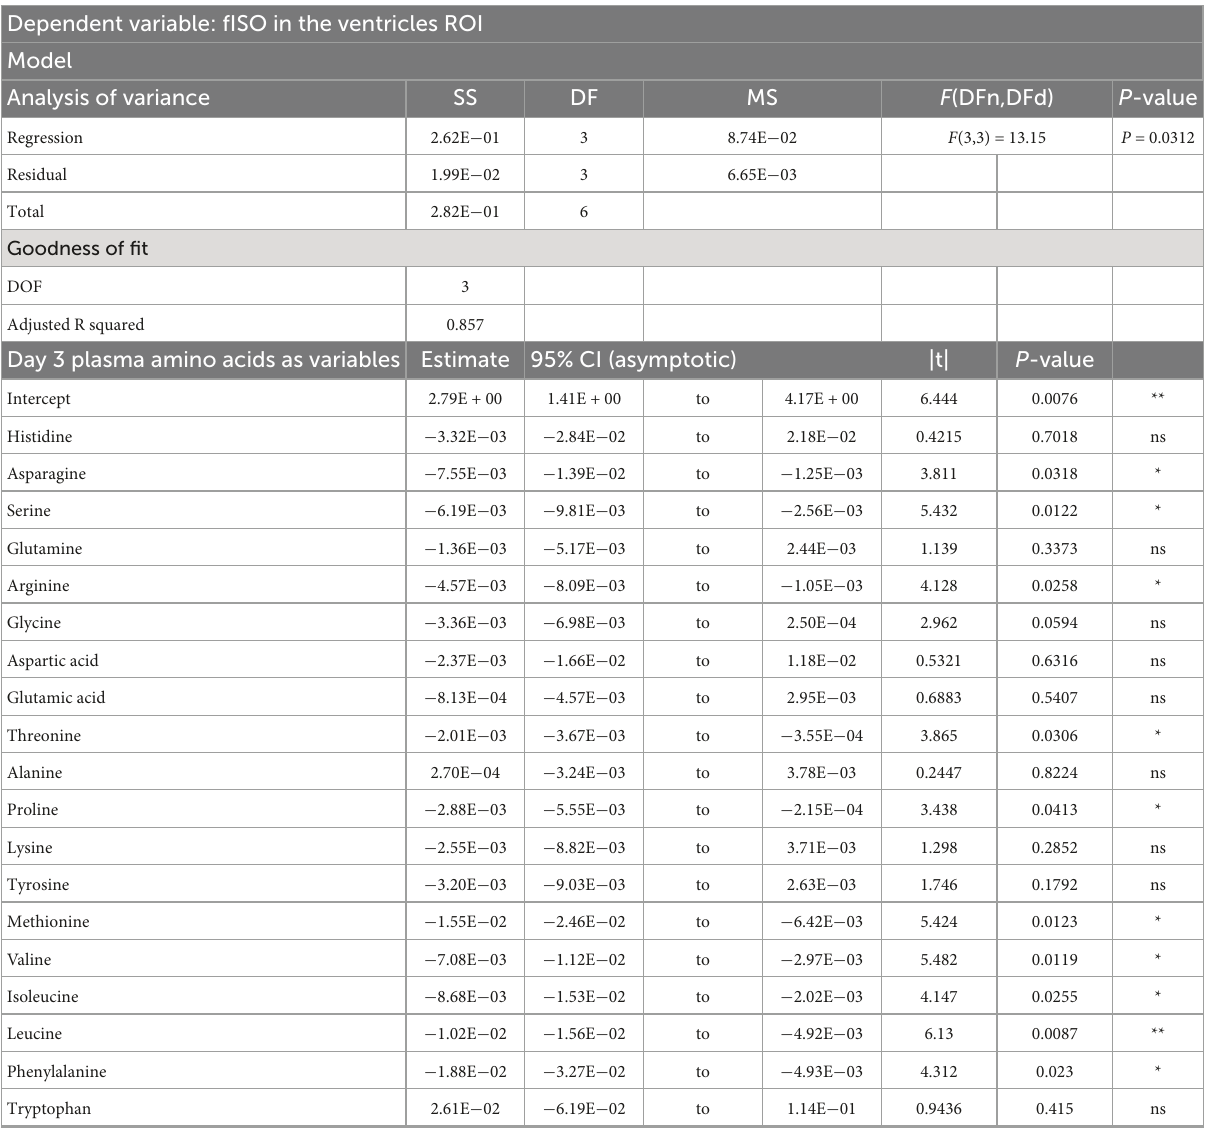
TABLE 2 Result of principal component regression (PCR) predicting the isotropic diffusion fraction (fISO) quantified from the ventricle ROI from the plasma amino acid panel at day three post-injury. Dependent variable: fISO in the ventricles ROI